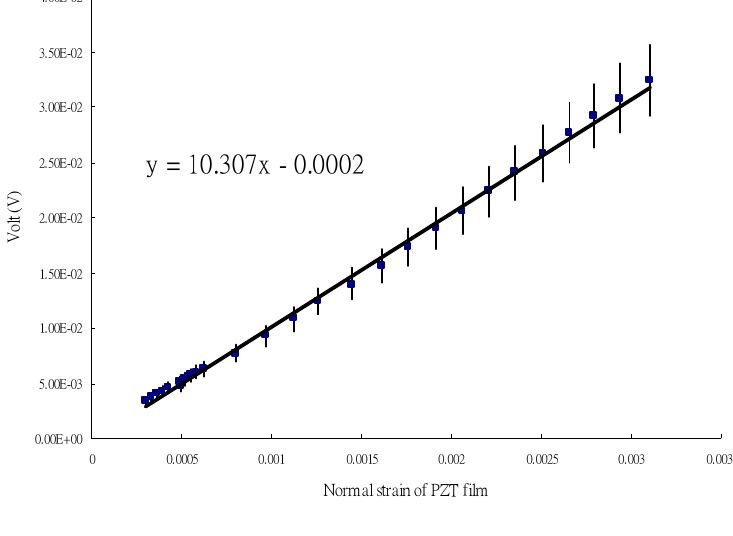
Figure 11. Sensing linearity testing of PZT